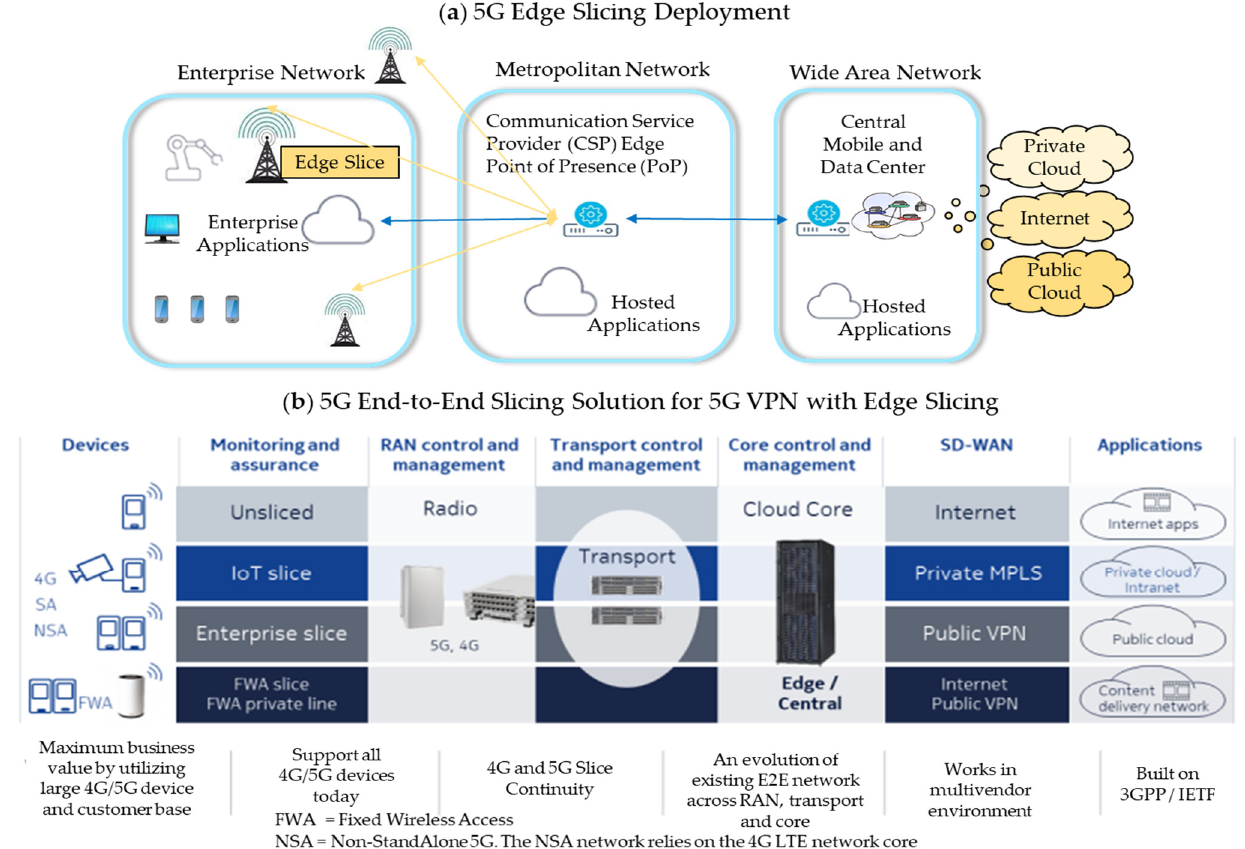
Figure 12. 5G Edge Slicing Technology Enabler in 5G VPN: ( a ) 5G Edge Sclicing Deployment, and ( b ) 5G End-to-End Slicing Solution for 5G VPN Edge Slicing